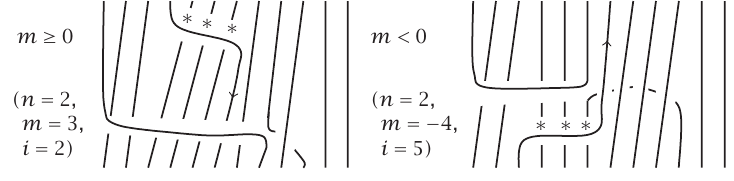
Figure 6.5 . The diagram D